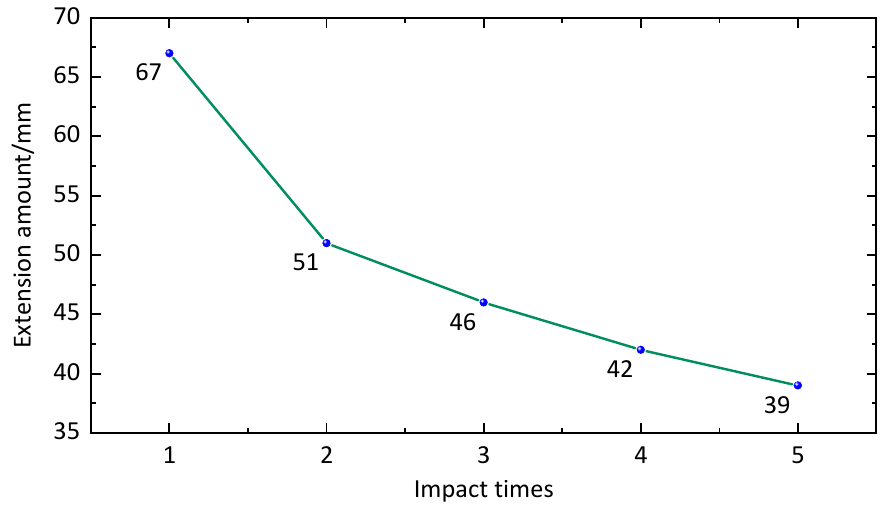
Figure 7. Relationship between impact times and extension amount of 21.5 mm cable.